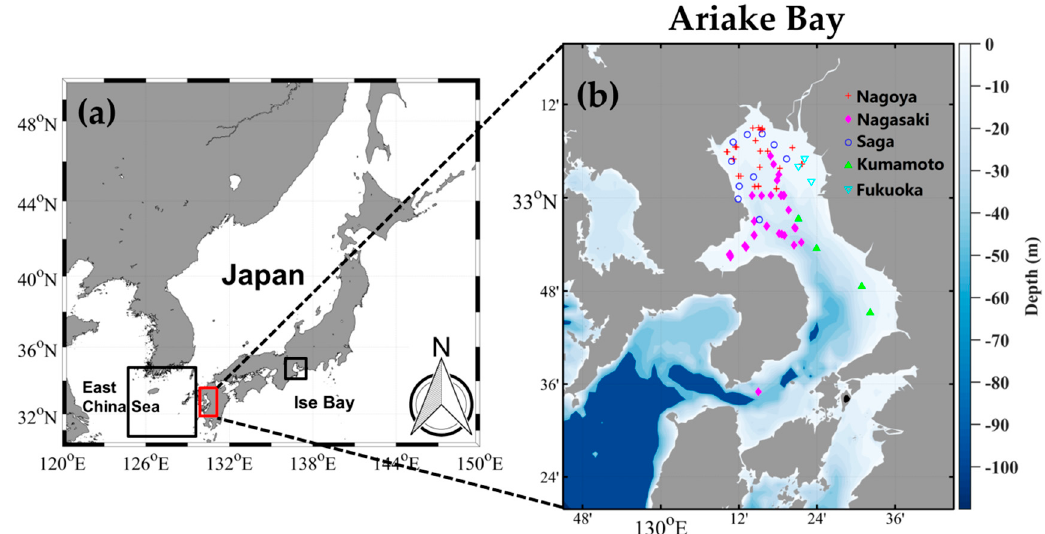
Figure 1. Location of Ariake Bay, Japan and sampling stations for this study. Water depth of the bay is shown in color. Station locations of data collected by Nagoya and Nagasaki universities, and Saga, Kumamoto, and Fukuoka Fishery Research institutes (Table 1) are shown by color symbols.